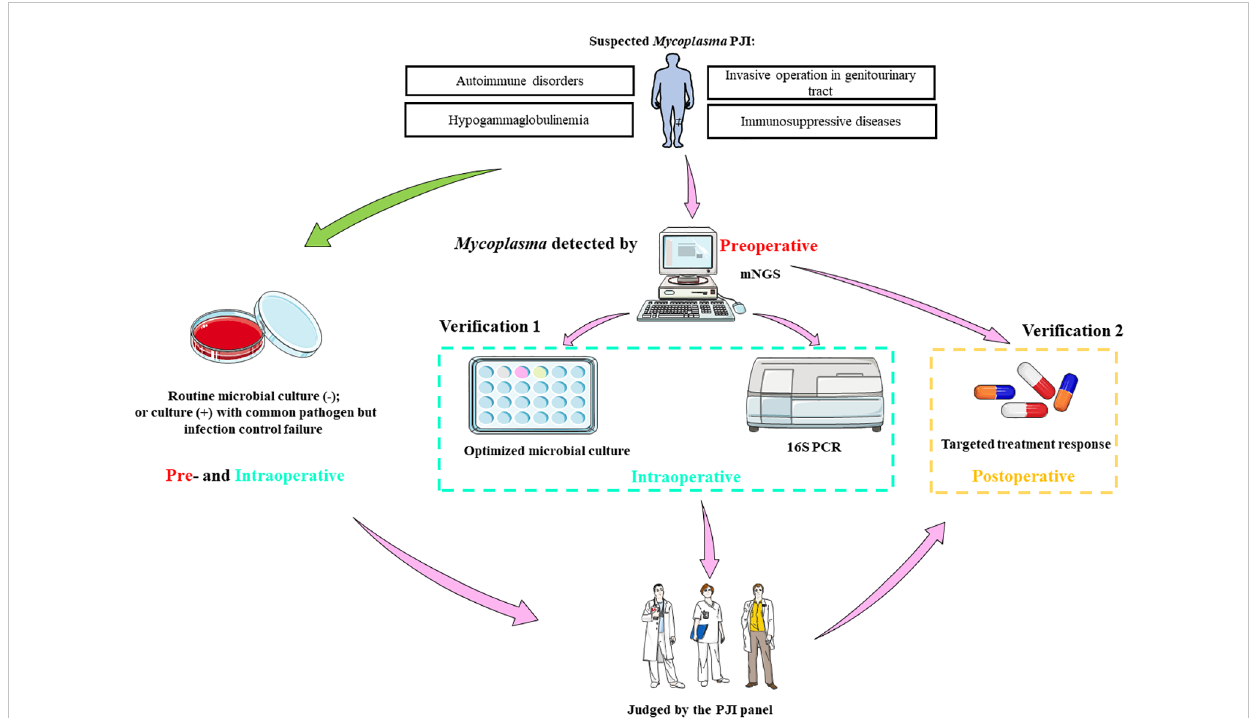
FIGURE 2 The optimized and standardized procedure based on mNGS for Mycoplasma PJI. mNGS, metagenomic next-generation sequencing; PCR, polymerase chain reaction; PJI, periprosthetic joint infection; -, microbial culture negative; +, microbial culture positive. Parts of the fi gure were drawn by using pictures from Servier Medical Art. Servier Medical Art by Servier is licensed under a Creative Commons Attribution 3.0 Unported License